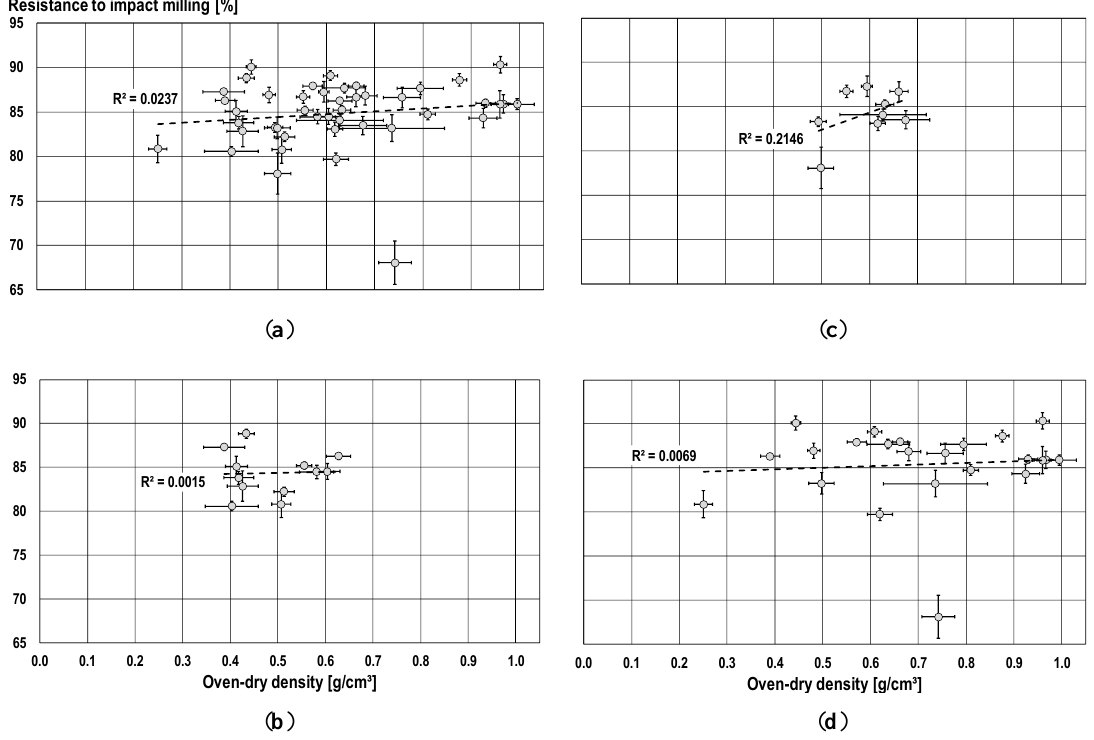
Figure 1. The relationship between the average oven-dry density and Resistance to Impact Milling (RIM): ( a ) all wood species (y = 3.1629x + 82.887); ( b ) softwoods (y = 1.1035x + 83.791); ( c ) ring- and semi-ring-porous hardwoods (y = 19.634x + 72.545); and ( d ) diffuse-porous hardwoods (y = 1.8475x + 84.086).